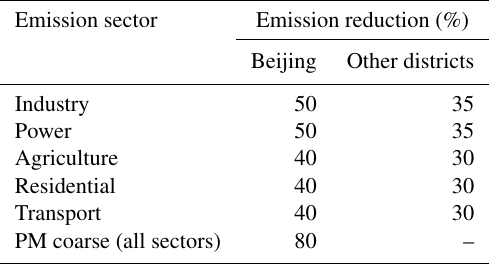
Table 6. Emission controls during APEC period. Emission sector Emission reduction (%)